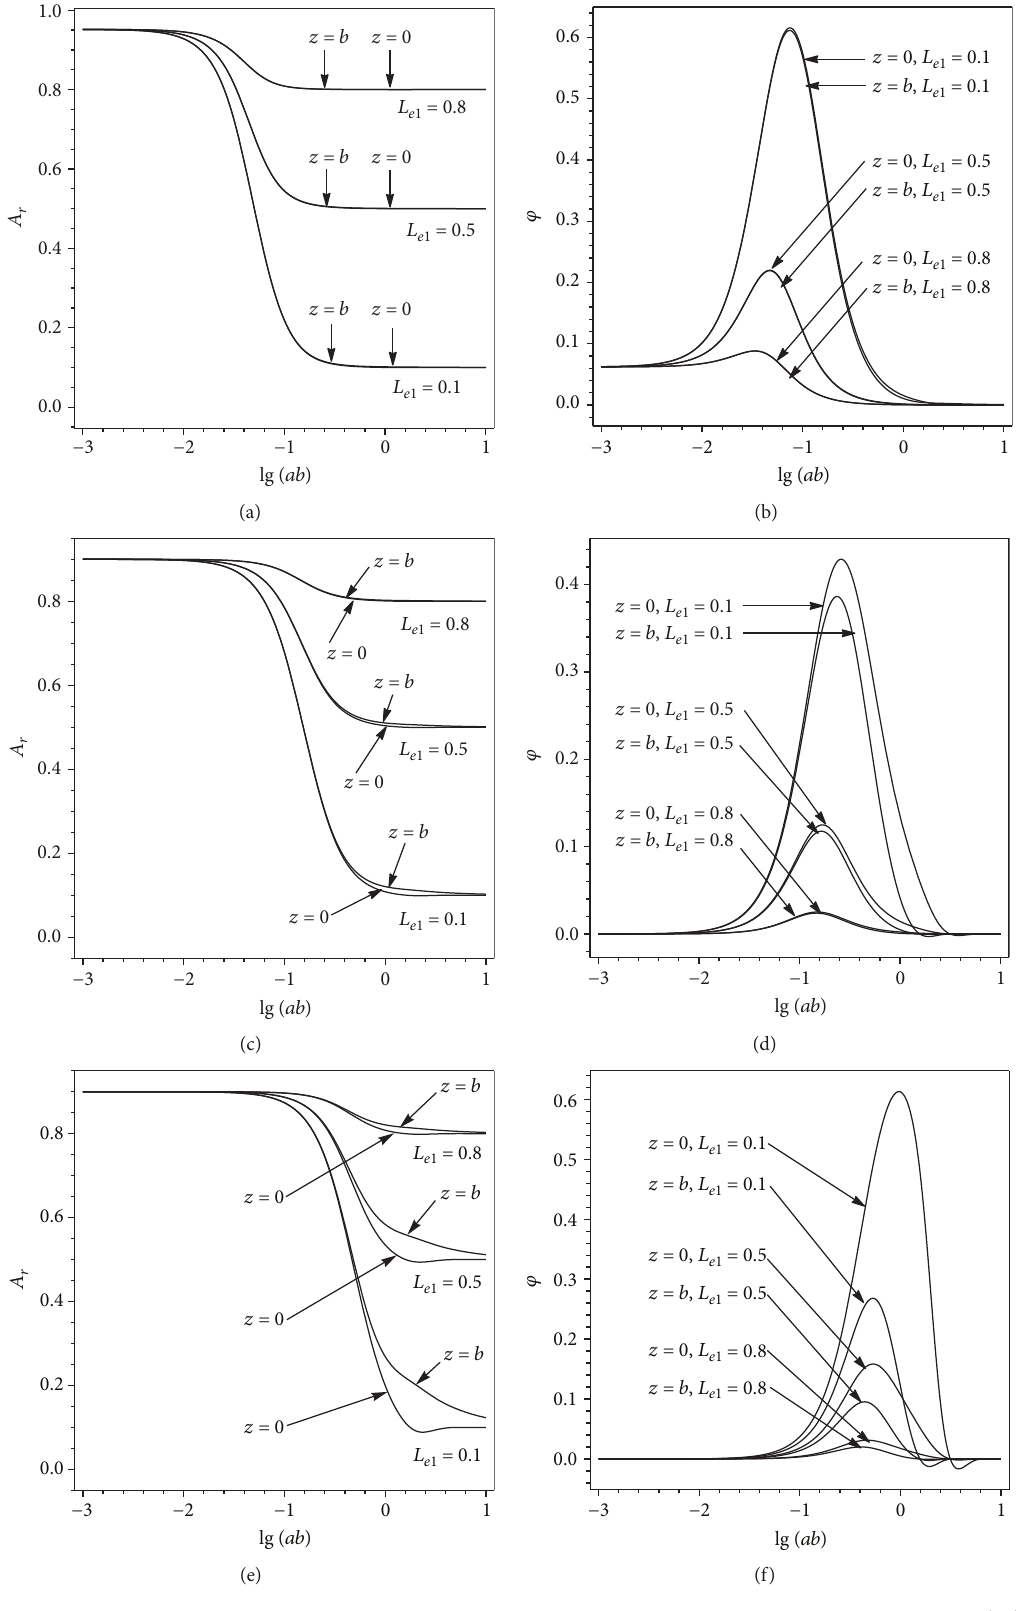
Figure 10: Changes of amplitude ratio A and phase shift φ at the top z = b and bottom z = 0 of the con fi ned aquifer with lg ab for di ff erent r ′ ≡ values of θ and L when L 0 9 . (a, b) A r and φ for θ = 1 ; (c, d) A r and φ for θ = 10 ; and (e, f) A r and φ for θ = 100 e 1 e